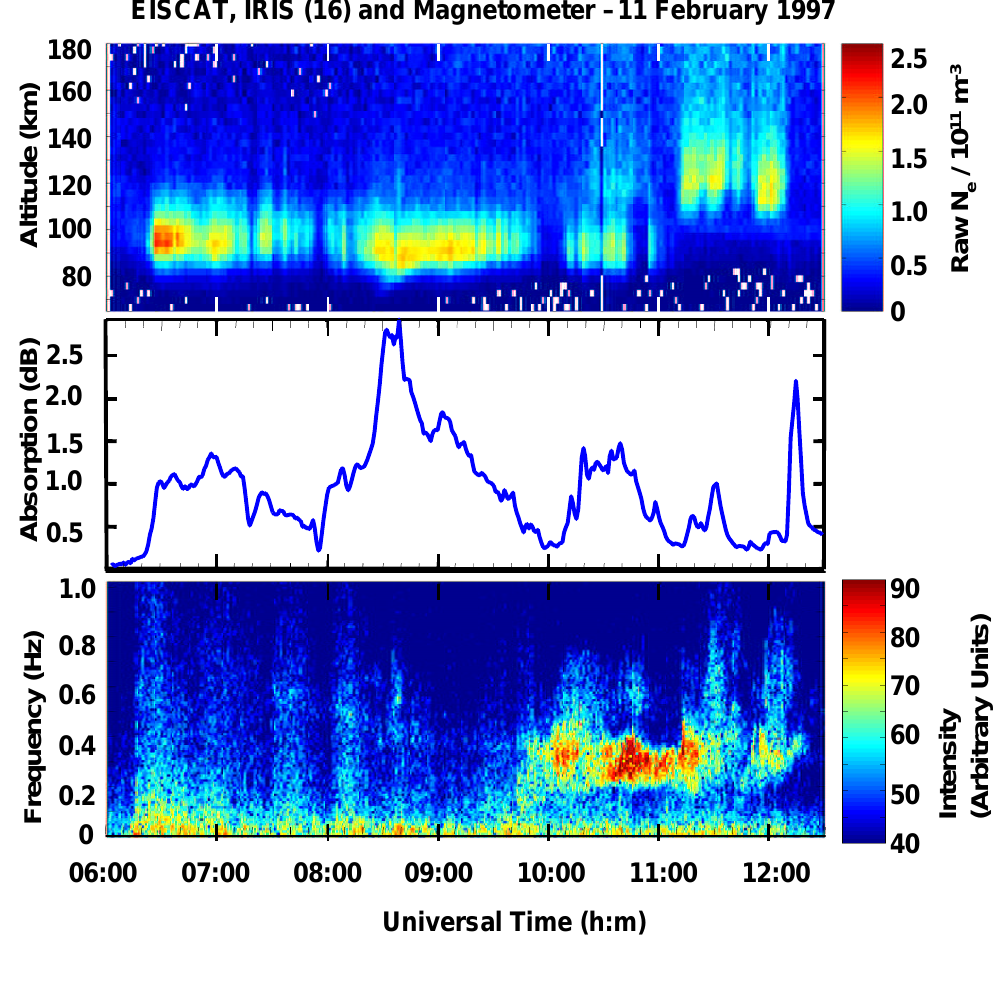
Fig. 3. The top panel shows the EISCAT raw electron density, scaled from the returned power. The middle panel shows the absorption time series from beam 16 of IRIS. The bottom panel is a spectrogram, from the pulsation magnetometer at Kilpisj¨arvi, with arbitrary units of